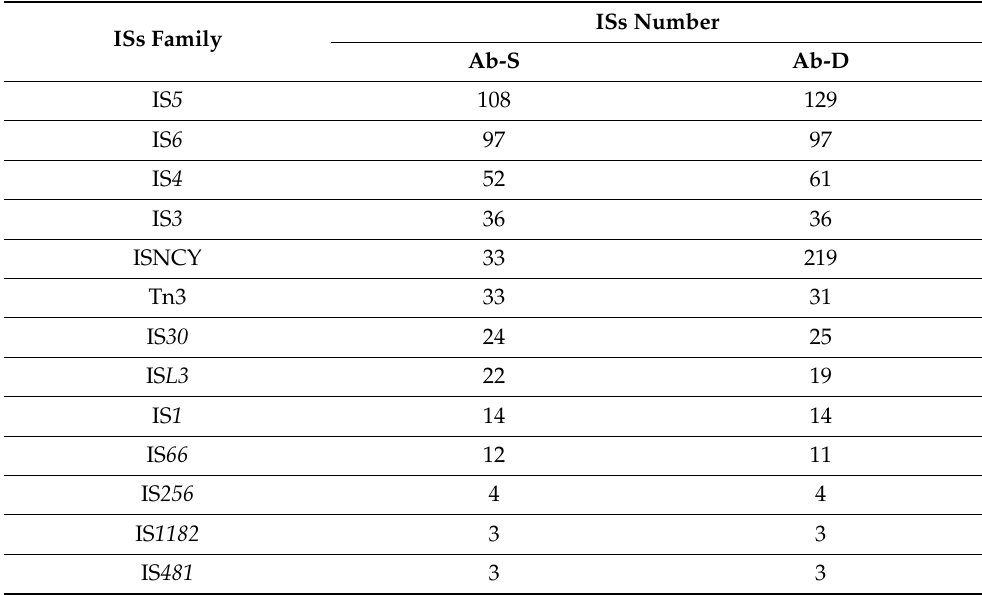
Table 3. Number of IS families found by ISFinder in Ab-S and